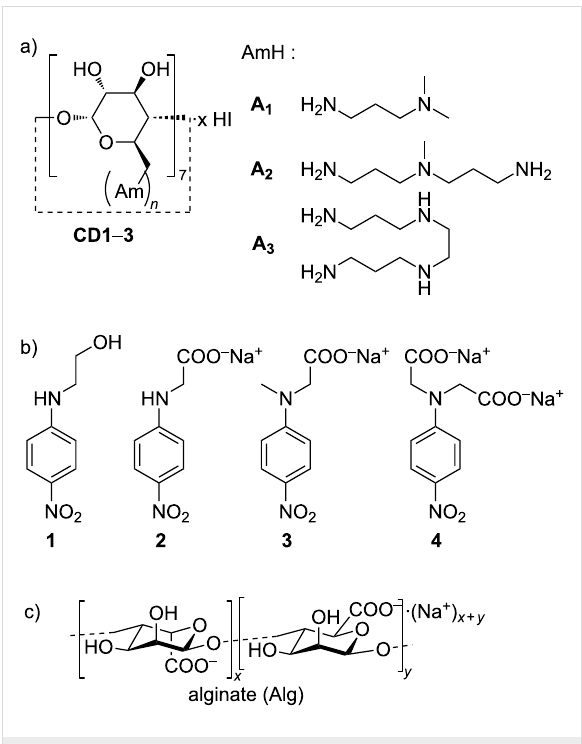
Figure 1: Structures of: a) AmCDs CD1 – 3 ; b) p -nitroaniline guests 1 – 4 ; c) sodium alginate